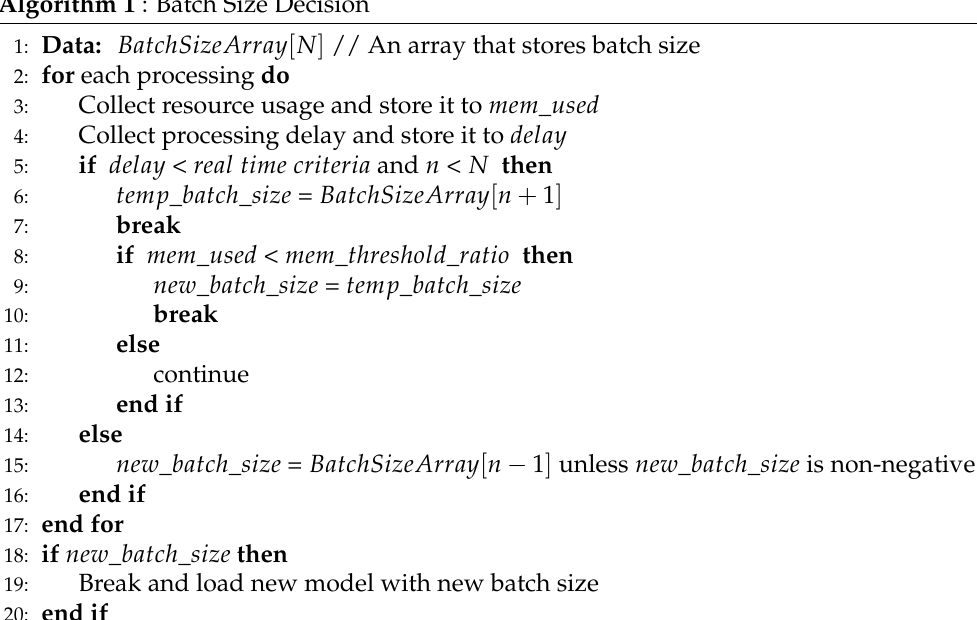
Algorithm 1 : Batch Size